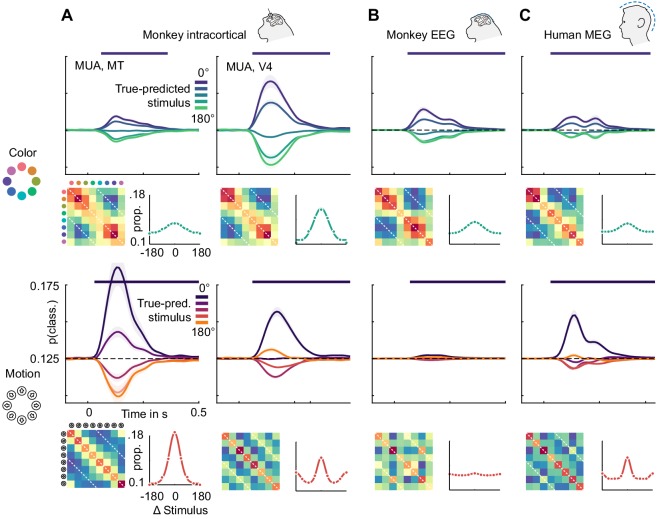
Color and motion direction tuning.Color and motion direction tuning in (A) MT (left), V4 (right), (B) monkey EEG and (C) human MEG. Shown is, for each area or signal type, first: the temporally resolved prediction probability as a function of the distance between true and predicted stimulus. The dark blue line indicates the probability of a stimulus being predicted correctly (classifier accuracy), the green (color) and orange (motion) lines the probability of a stimulus being predicted as the opposite in the circular stimulus space. Second: the confusion matrix, indicating prediction probabilities for all stimulus combinations. Third: A representation tuning curve, indicating prediction probabilities as a function of distance between true and predicted stimulus at the time of peak accuracy. For color, tuning is always unimodal, with opposite-classifications having the lowest probability. For motion direction, V4, EEG and MEG, but not MT tuning is bimodal, with opposite-classifications having a higher probability than some intermediate stimulus distances.